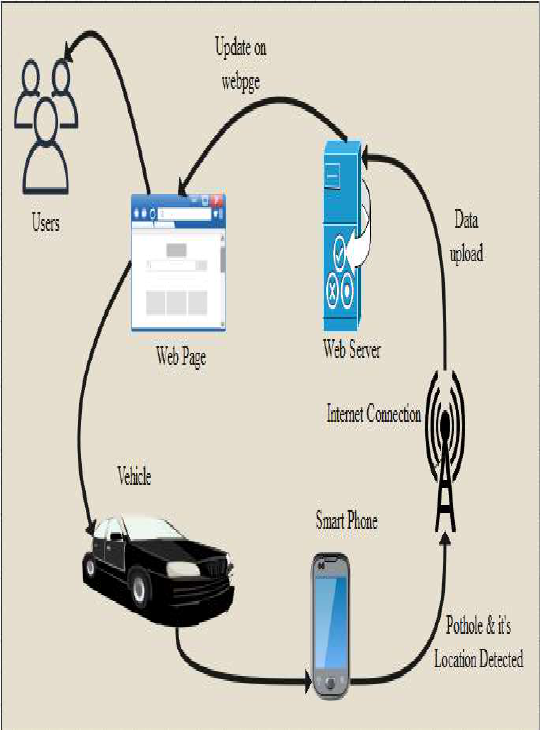
Figure 5 . Architecture of road pavement information sharing system to